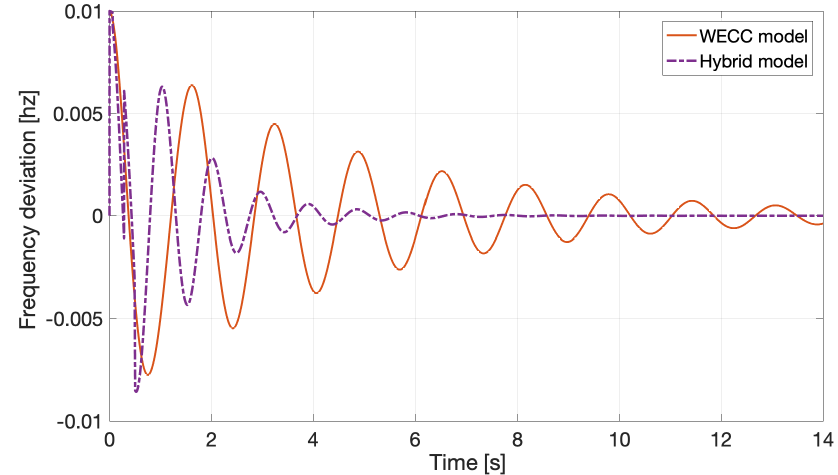
Figure 9. First generator frequency deviation in the first area.